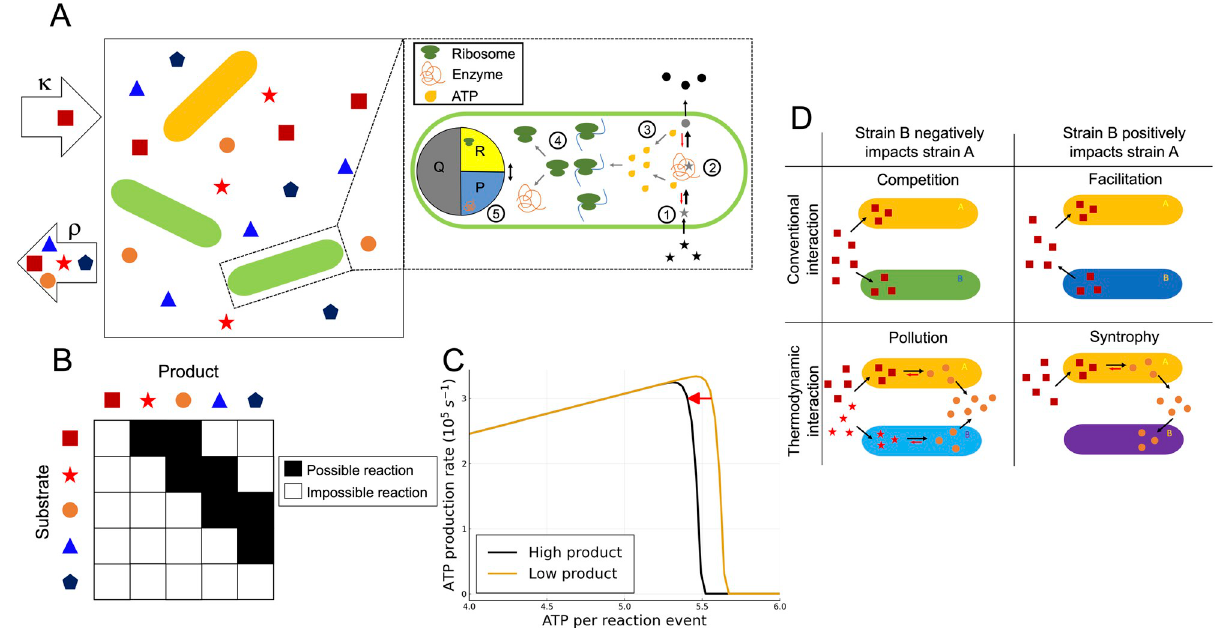
Fig 1. Overview of the thermodynamic microbial community model. A : A single substrate is supplied with rate κ , and diversifies into secondary substrates (metabolites) through uptake, metabolism and leakage by the microbial populations. All metabolites are diluted out of the system with constant dilution factor ρ . The magnification shows a schematic of the cellular sub-model, comprising five key processes: (1) uptake of metabolites, (2) their breakdown into other metabolites (Eqs 12 and 13), (3) generation of ATP through this process (Eq 8), and (4) the use of this ATP to drive protein synthesis (Eqs 5 and 6). (5) The cell proteome is partitioned into a constant housekeeping protein compartment ( Q ), a ribosome compartment ( R ), and a metabolic protein compartment ( P ). B : An example matrix of possible metabolic reactions. Metabolites can only react to form new metabolites that are one or two positions lower on the free-energy hierarchy. C : The thermodynamic trade-off that emerges from our model; ATP production rate increases linearly with an increase in ATP per reaction event ( η ), up to the point where thermodynamic inhibition becomes significant. The position of optimal η value shifts as environmental metabolite concentrations change. D : The four possible species interaction types in our model. Competition and facilitation are present here like in all consumer-resource models that allow for the production of resources. In addition, there are two thermodynamic interaction types: “pollution” where one species produces a metabolite that causes thermodynamic inhibition of the other species, and “syntrophy” where a species consumes a metabolite that is thermodynamically inhibiting another species (and thus benefiting it).